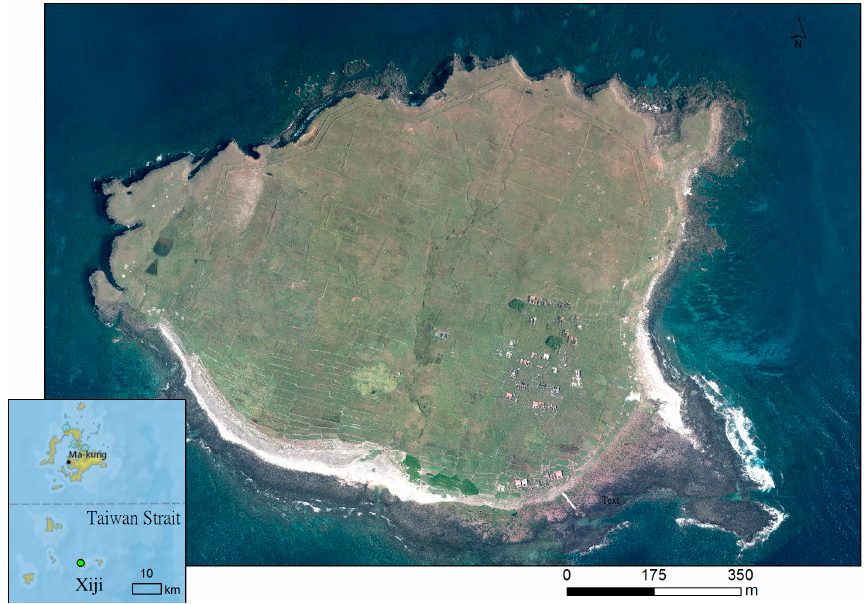
Figure 1. Color orthophoto image from the Xiji Island in Taiwan Strait.